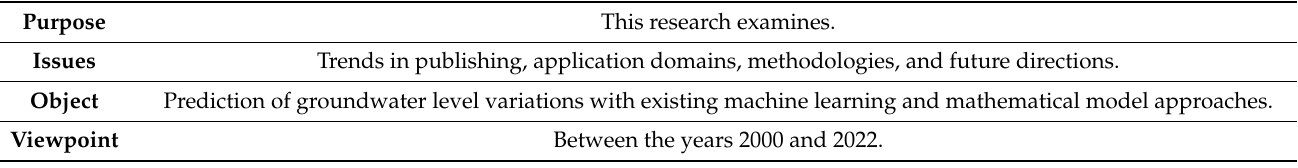
Table 2. Goal-Question-Metric espoused from [88].